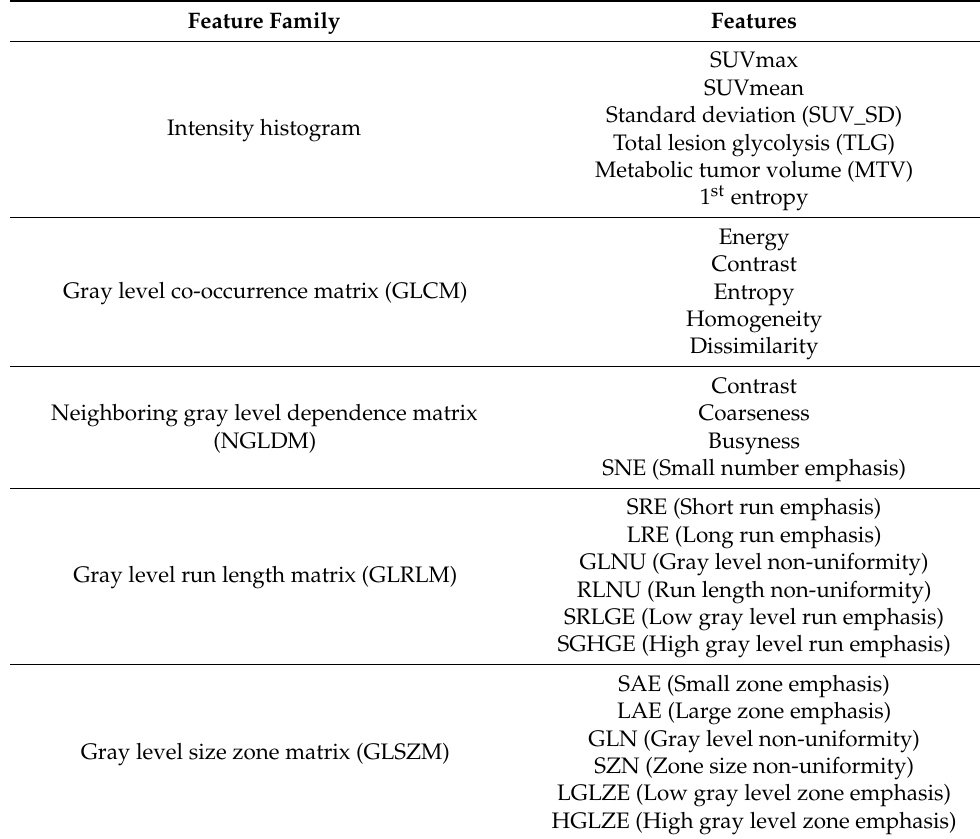
Table 2. Index of textural features in global, local, and regional areas. Feature Family